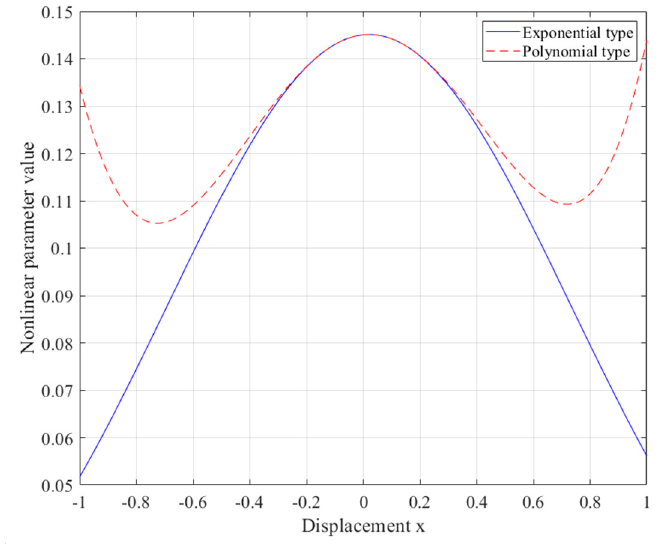
Figure 2. Comparison of the power series curve in exponential and polynomial function.